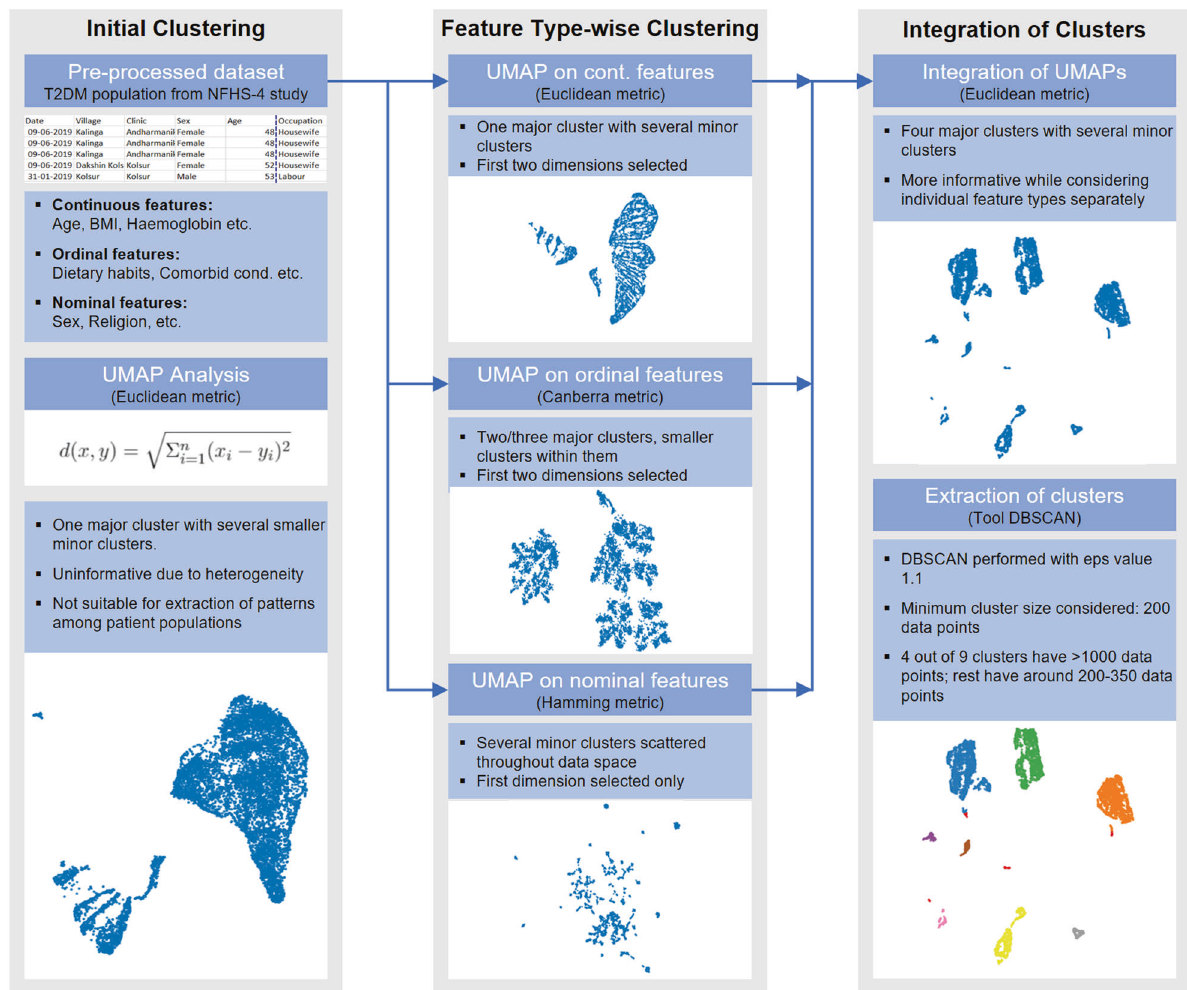
Fig. 1 Work fl ow describing the analysis of the T2DM-NFHS-4 Dataset. A visualisation for the novel feature type-wise clustering paradigm used in the study, to account for the bias of UMAP towards over representation of continuous variables during dimension